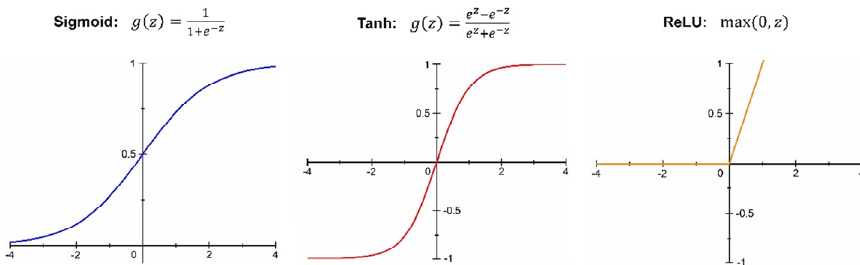
Figure 4. Activation functions of Sigmoid, Tanh, and ReLU.